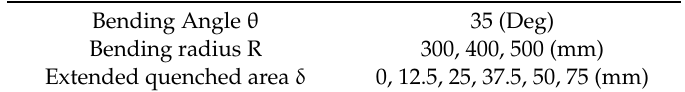
Table 6. Analytical conditions.